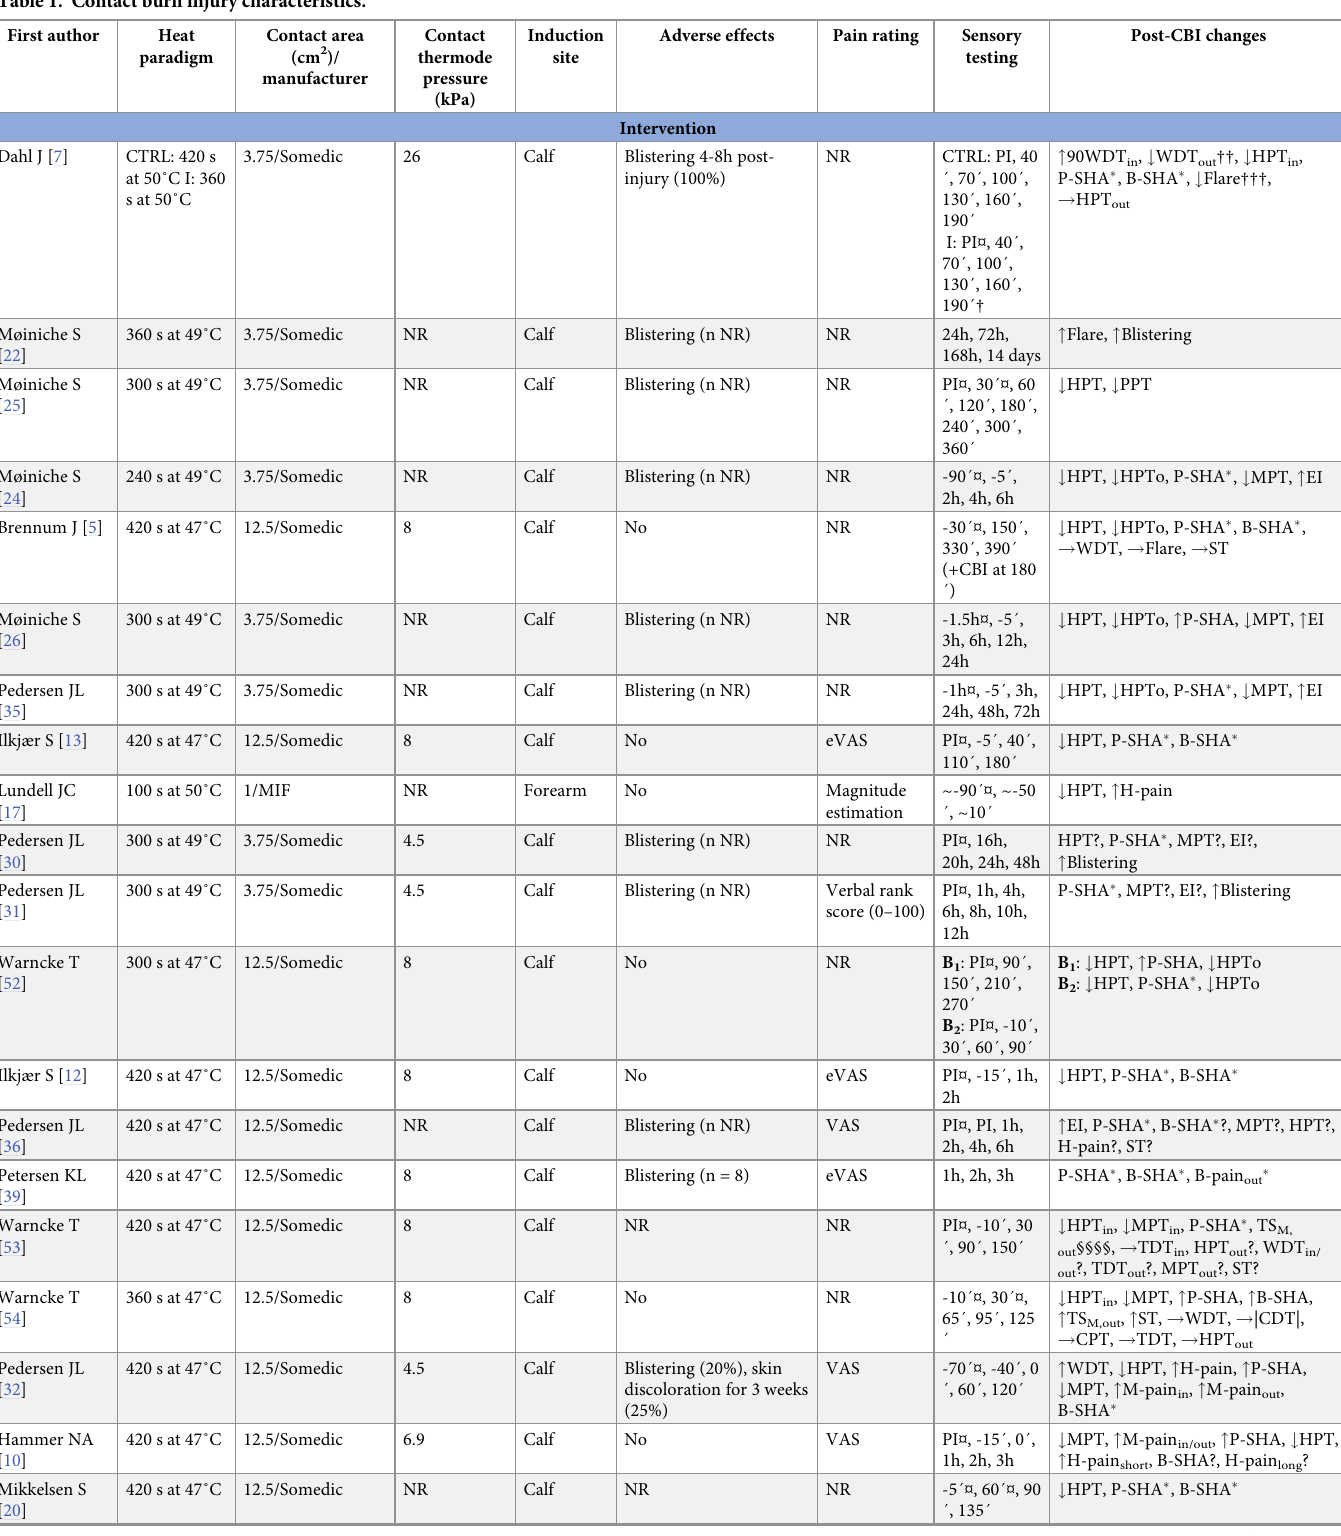
Table 1. Contact burn injury